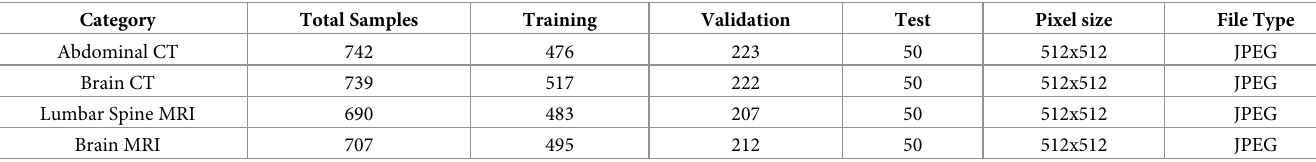
Table 1. Data distribution across the image